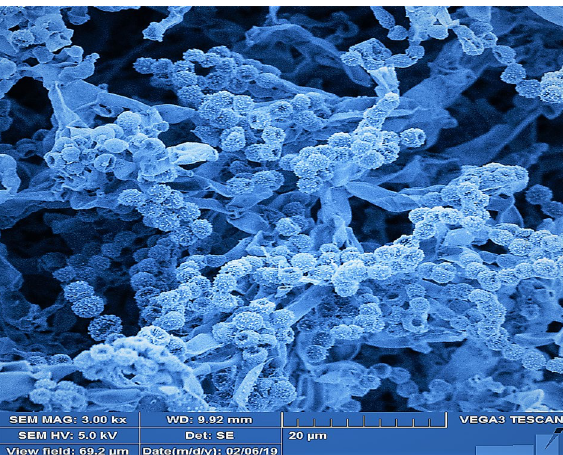
Figure 3. SEM image of Streptomyces smyrnaeus UKAQ_23.